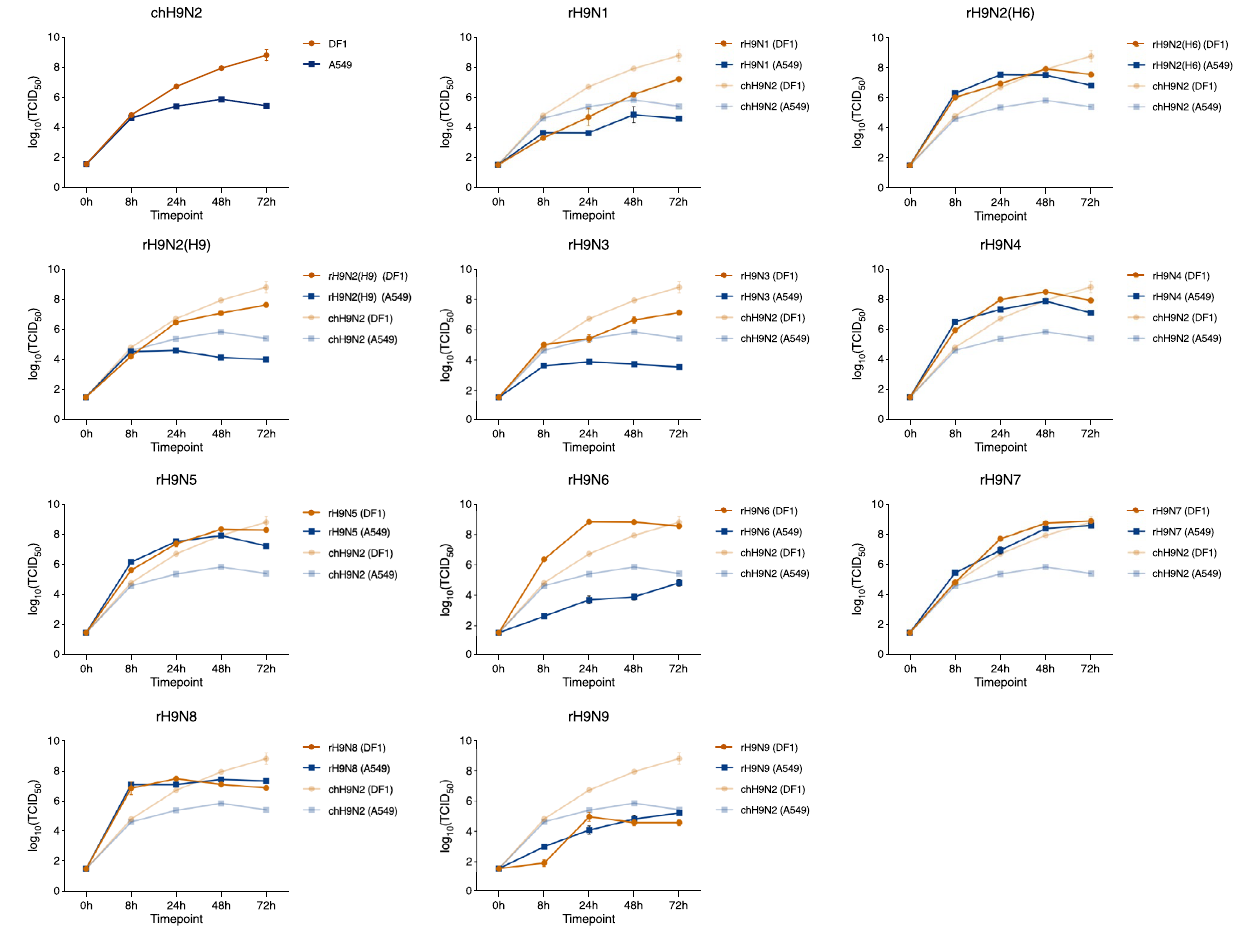
Figure 2. Replication efficiency of the rH9Nx reassortants with intact neuraminidase stalks in DF-1 (orange) and A549 (blue). The log 10 (TCID 50 ) value at time point 0 h is based on the starting TCID 50 value. Error bars represent the standard error of the